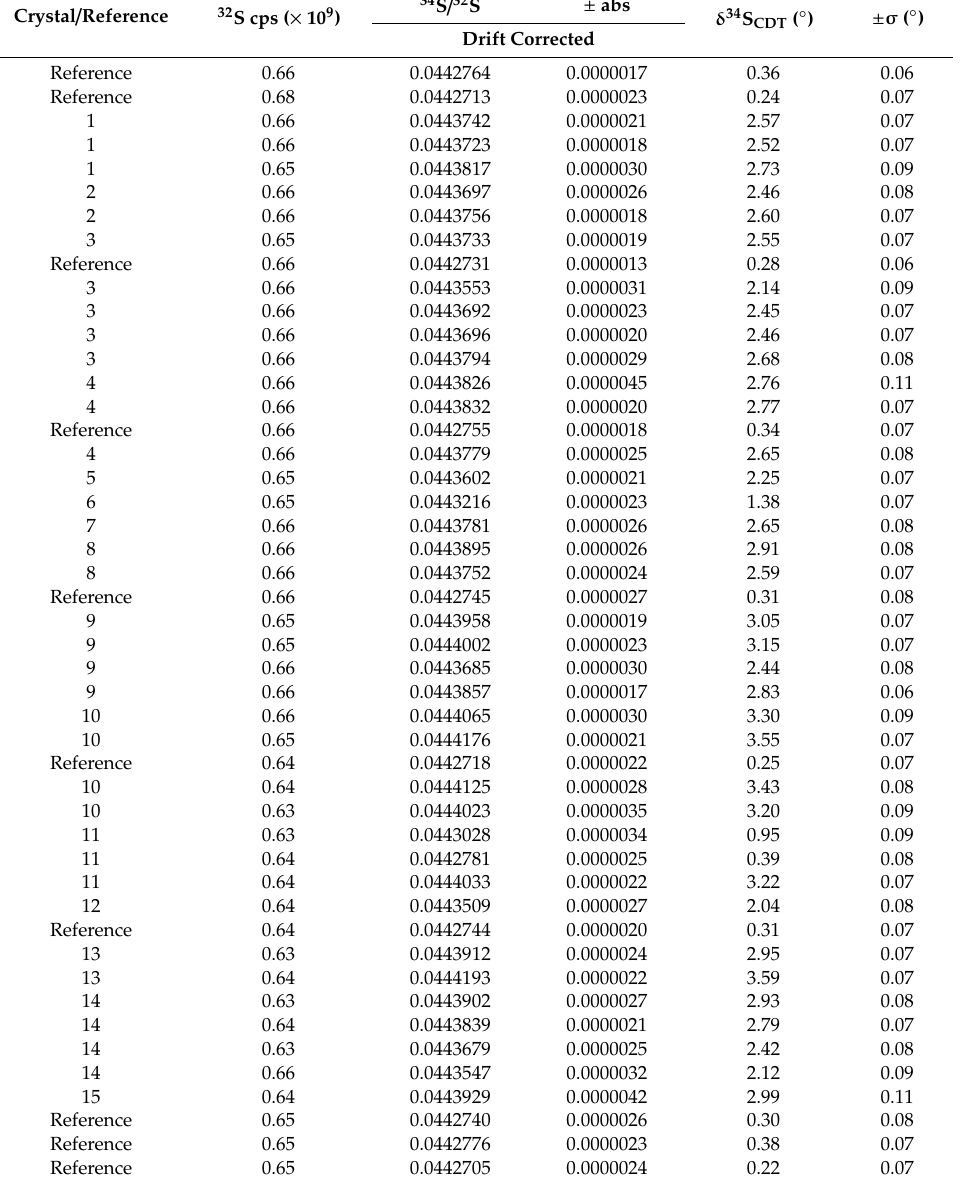
Table 1. SIMS-analyses of δ 34 S in chalcopyrite in sample 185 m. Sample and Trout Lake chalcopyrite reference material, in analytical